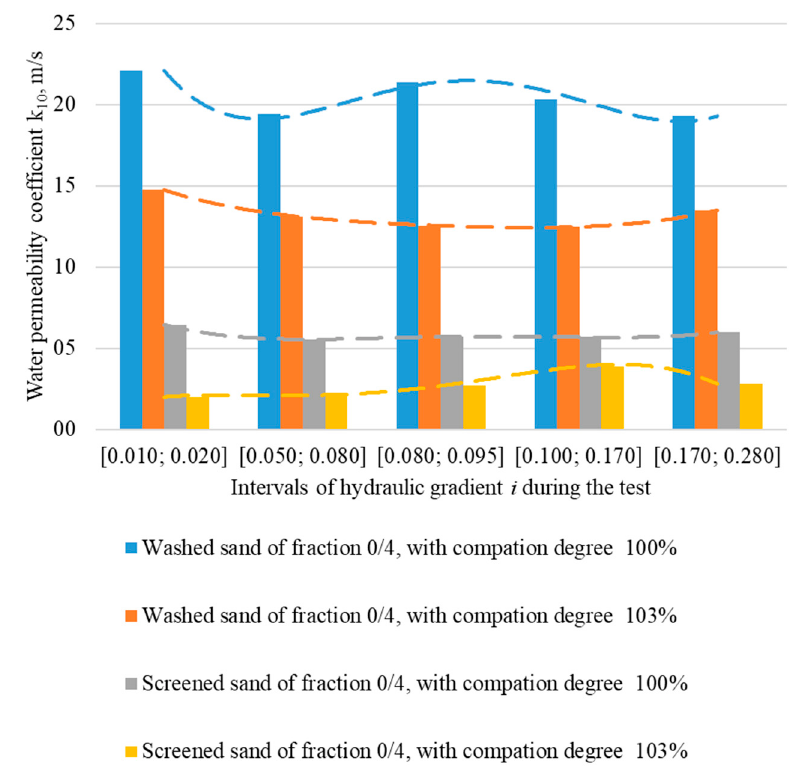
Figure 5. Water permeability coe ffi cient value correlation with di ff erent the hydraulic gradient during test.